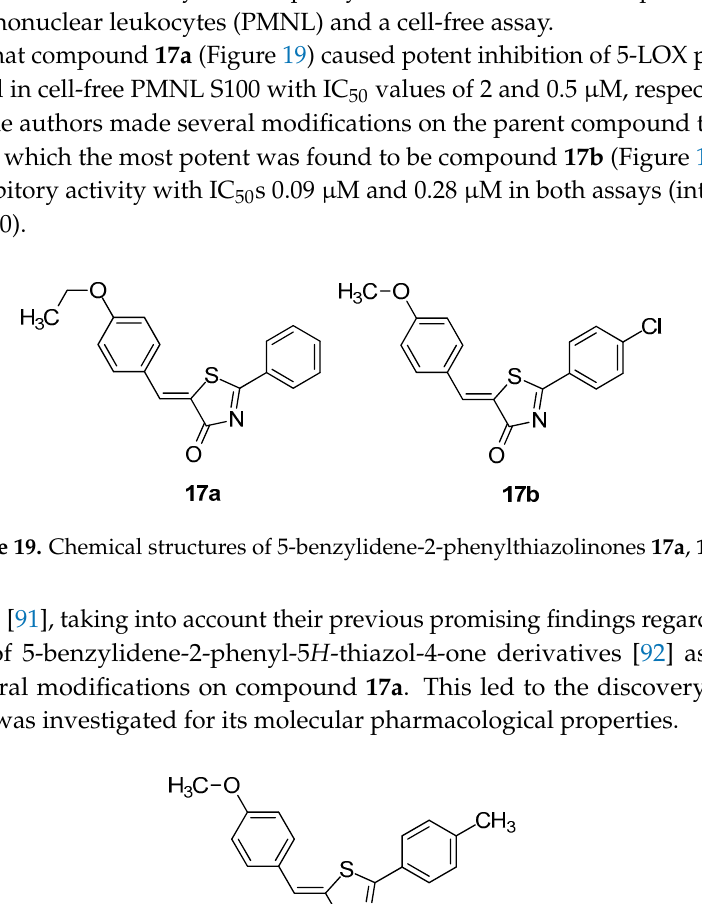
Figure 20. Chemical structure of 5-benzylidene-2-phenyl-5 H -thiazol-4-one derivative 18 .